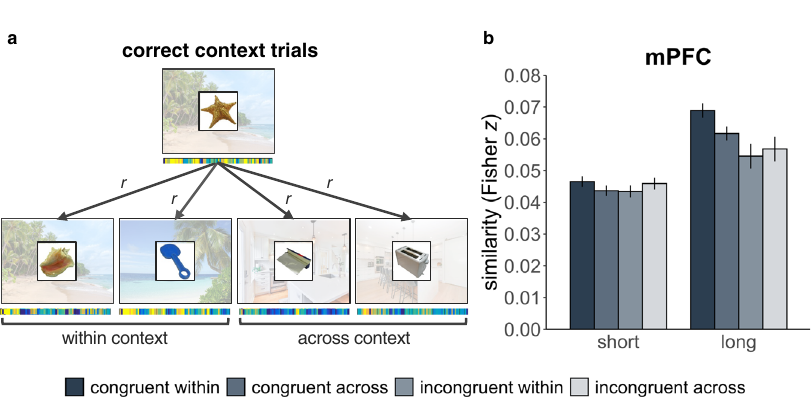
Fig. 4 | Pattern similarity analysis in the mPFC during retrieval of congruent and incongruent object-context pairs. a Schematic example of our analysis approach. Patterns for trials where participants successfully retrieved the context associated with the presented object (regardless of whether they retrieved the speci fi c scene) were extracted from the mPFC and correlated within and across context, separately for congruent and incongruent trials. This example depicts congruentbeachstimuli,butthesameanalysiswasappliedtoincongruentbeaches, as well as congruent and incongruent kitchens. Background scenes were not pre- sented during retrieval, but were retrieved from memory. b Resulting pattern simi- larityinthemPFCovertime,accordingtocongruency(congruent/incongruent)and